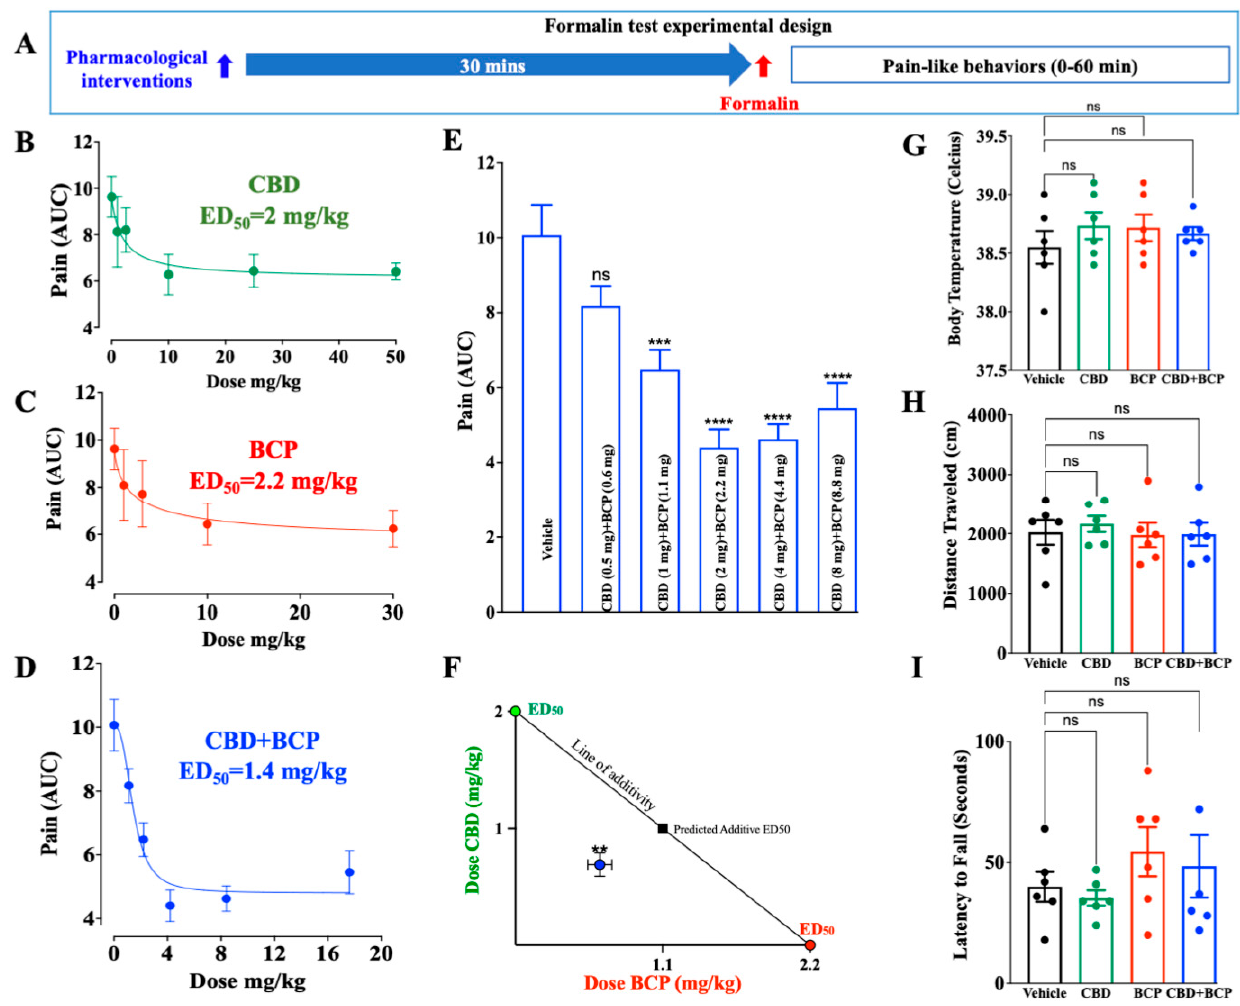
Figure 1. Experimental design ( A ). CBD ( B ) and BCP ( C ) individually and combined ( D , E ) produce dose-dependent analgesia. Isobolographic analysis of the CBD and BCP in combination ( F ). Effects of BCP and CBD alone and in combination on body temperature ( G ), locomotor activity ( H ), and motor coordination ( I ), n = *** p < 0.001, **** p < 0.0001 (compared to vehicle), ns: not significant (compared to vehicle).